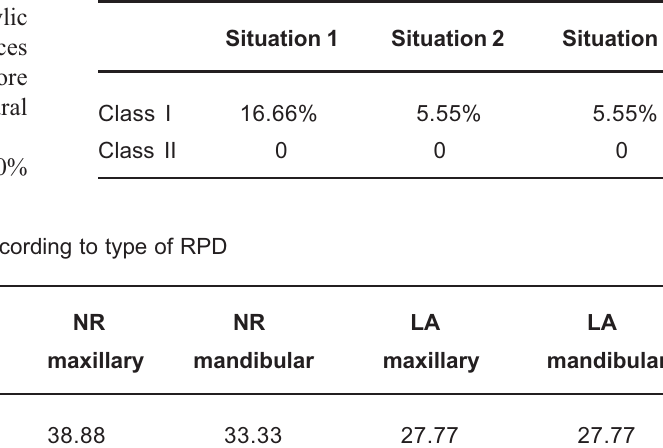
TABLE 2 - Prevalence indices grouped together into three possible